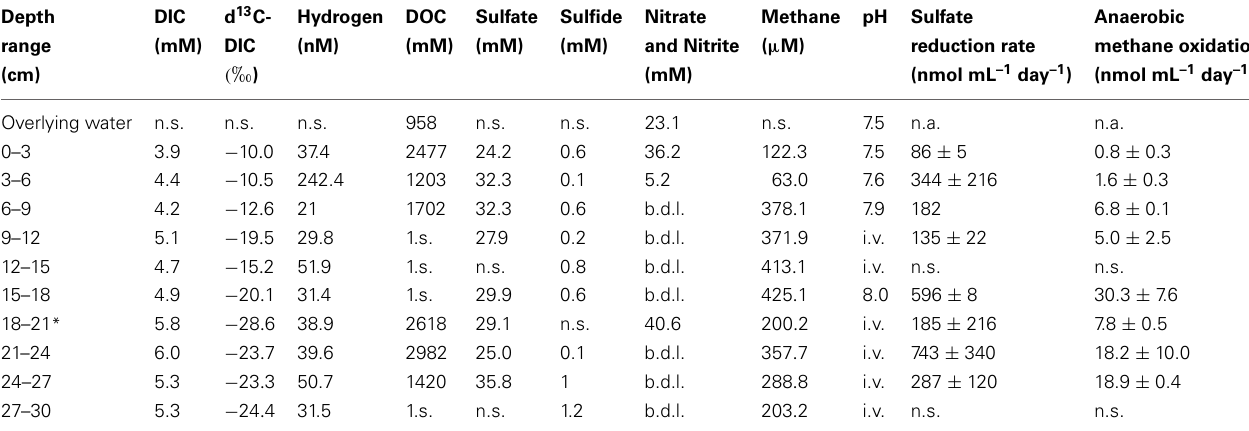
Table 2 | Geochemical data from site GB425, from which sediments were collected for these analyses in November 2010 (27 ◦ 33.1887N, 93 ◦